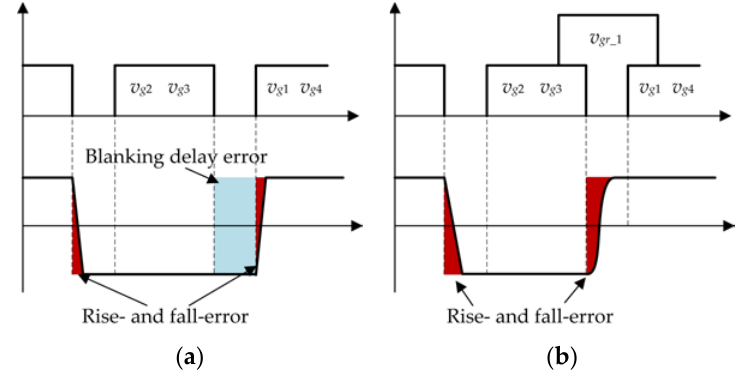
Figure 4. The pole voltage and voltage error of the ARSI and hard-switching inverters in a switching cycle when the output current is positive: ( a ) hard-switching inverters and ( b )